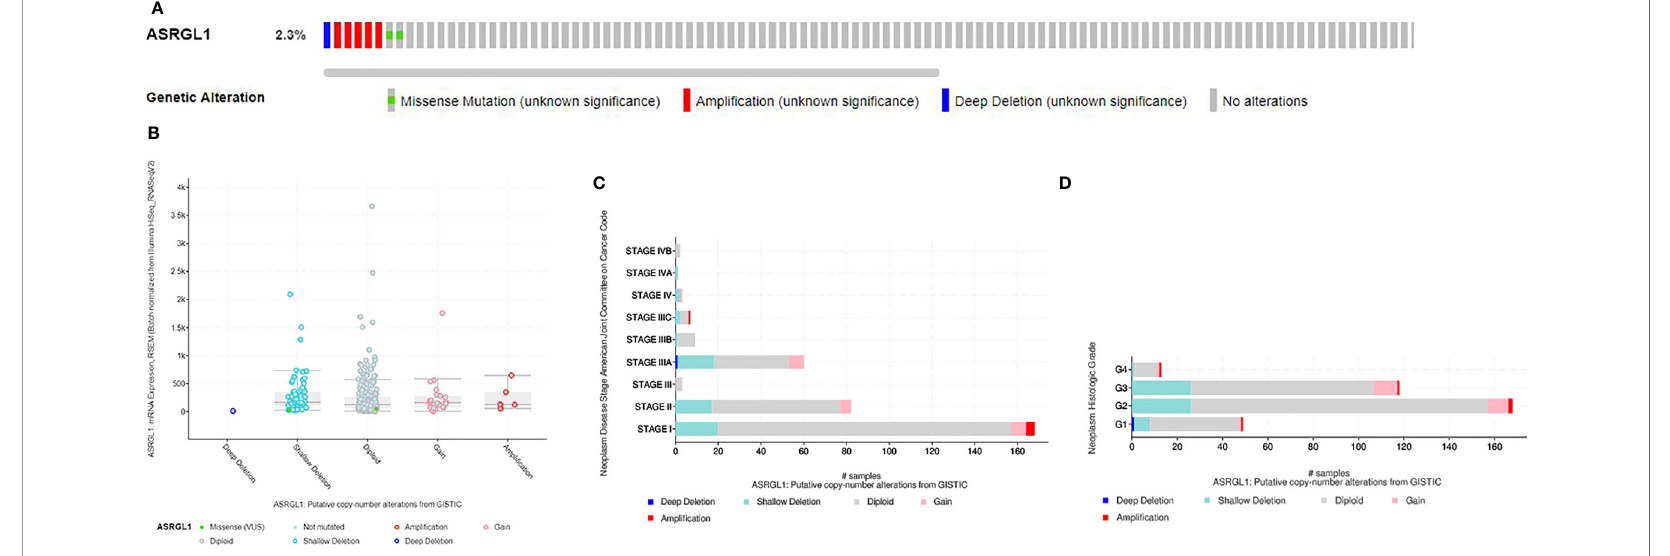
FIGURE 5 | The genomic alterations of ASRGL1 in HCC as identi fi ed in cBioPortal. (A) OncoPrint provides an overview of the genomic alterations of ASRGL1 in HCC based on the TCGA database. (B) ASRGL1 expression in different ASRGL1 CNV groups. ASRGL1 ampli fi cation (AMP) group, showing a signi fi cantly higher expression level. (C, D) Distribution of ASRGL1 CNV frequency in different stage and grade subgroups. The percentage on the right of the bar indicates the proportion of patients with ASRGL1 gain or AMP in this